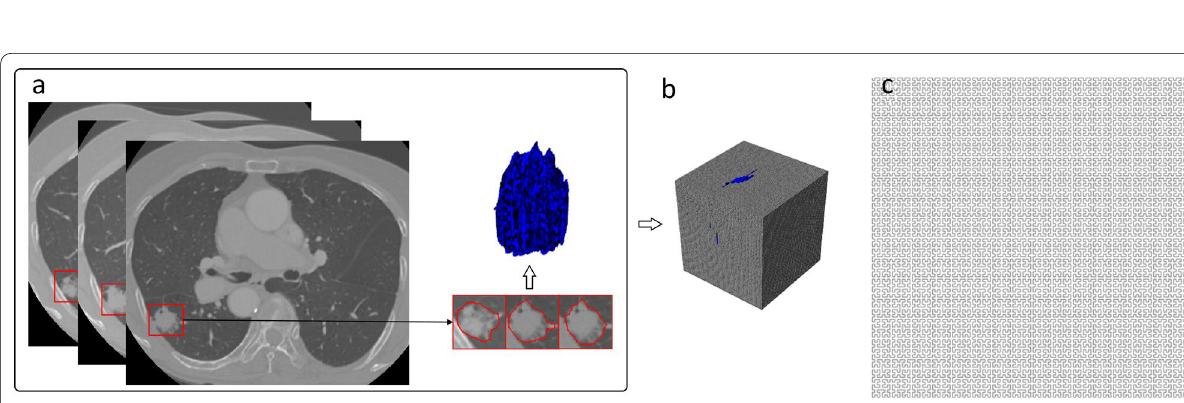
4 pixels using a three-dimensional ×